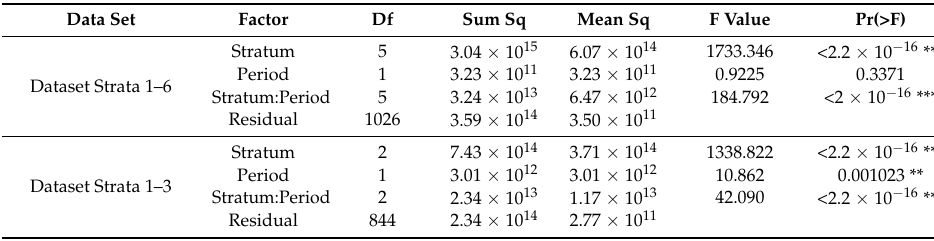
Table A6. Two-way ANOVA with interaction. Variable: Amount Paid for water and sewerage services considering the programme